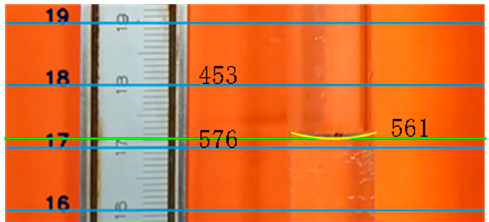
Figure 18. A schematic diagram showing the process used for measuring the metered neck level.